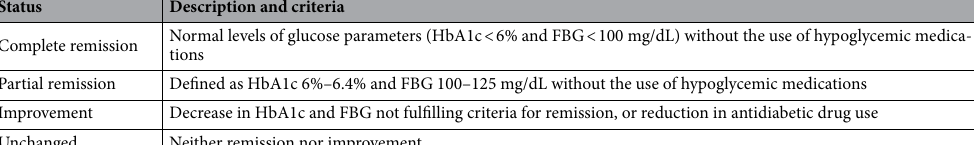
Table 1. Determination of the status of type 2 diabetes 17 . HbA1c Glycated hemoglobin; FBG fasting blood